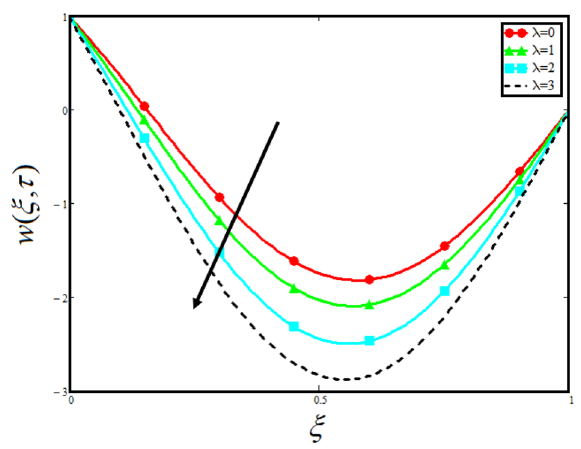
Figure 14. Variation in velocity of nanofluid against different values of (cid:31) when τ = 1 , φ hnf = 0.02 , Pr = 21 , Gr = 4 , G = 2 , α = 0.5 , β = 1.2 and Re = 1.2 .